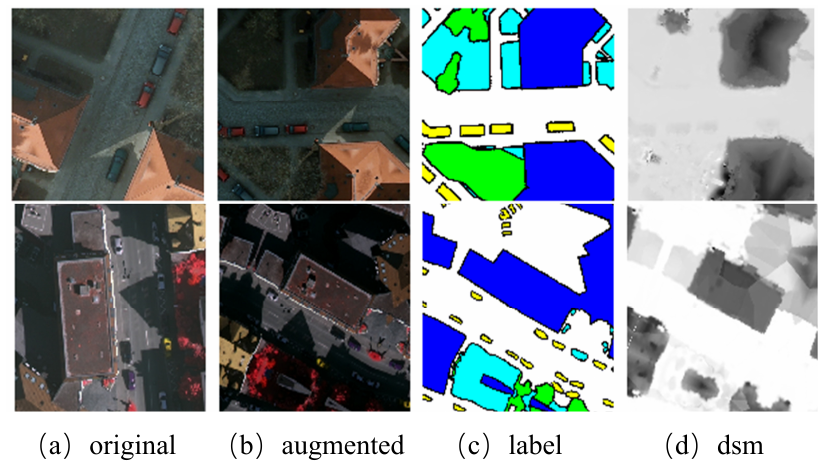
Figure 5. Illustrations about samples of Potsdam and Vaihingen dataset. Augmented means the image after the augmentation operation.